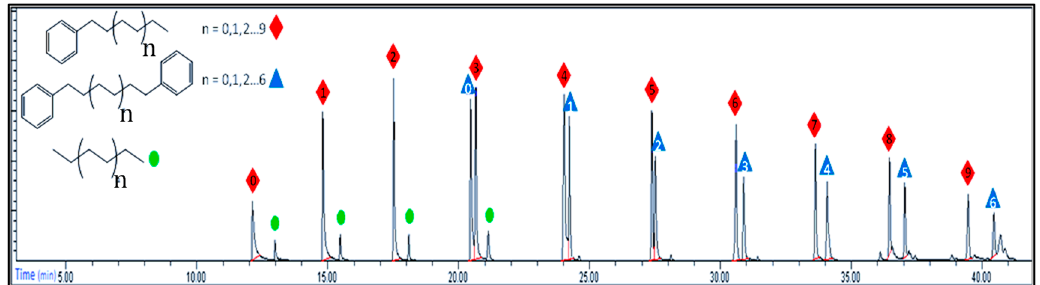
Figure 5. GC of raw oil (Exp. 3).